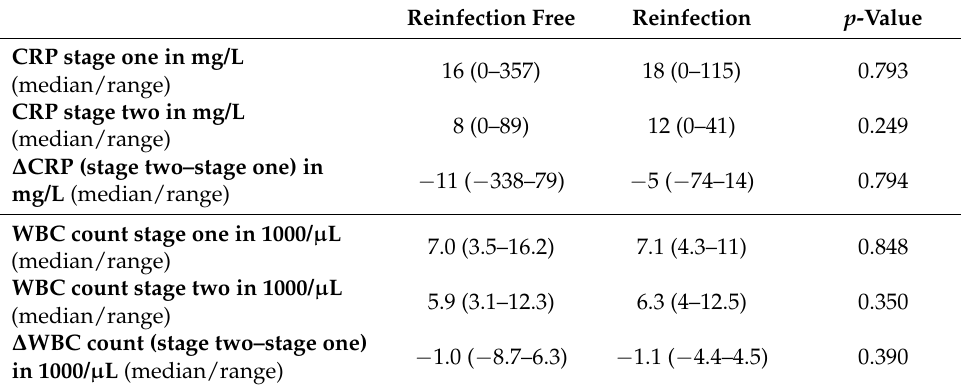
Table 1. Median values of CRP, WBC count, Δ CRP and Δ WBC count (CRP: C-reactive protein; WBC: white blood cell).